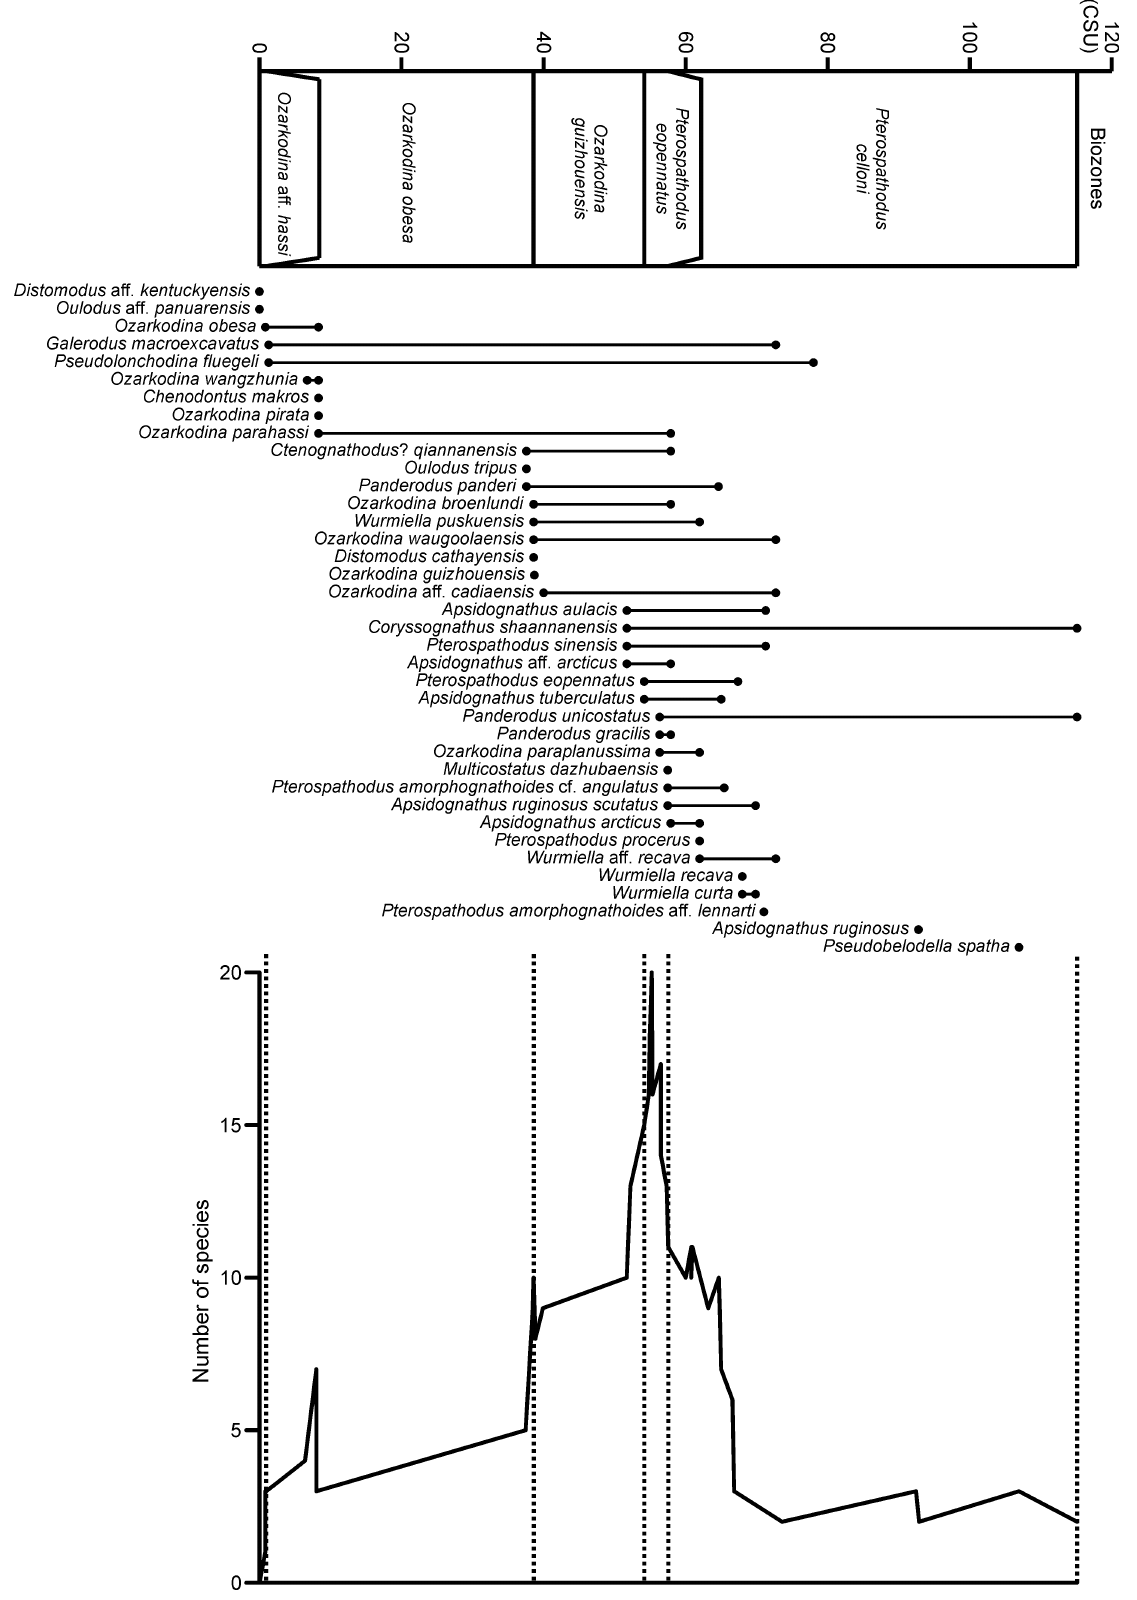
Fig. 4. Llandovery conodont species diversity of the Upper Yangtze Platform based on the conodont composite